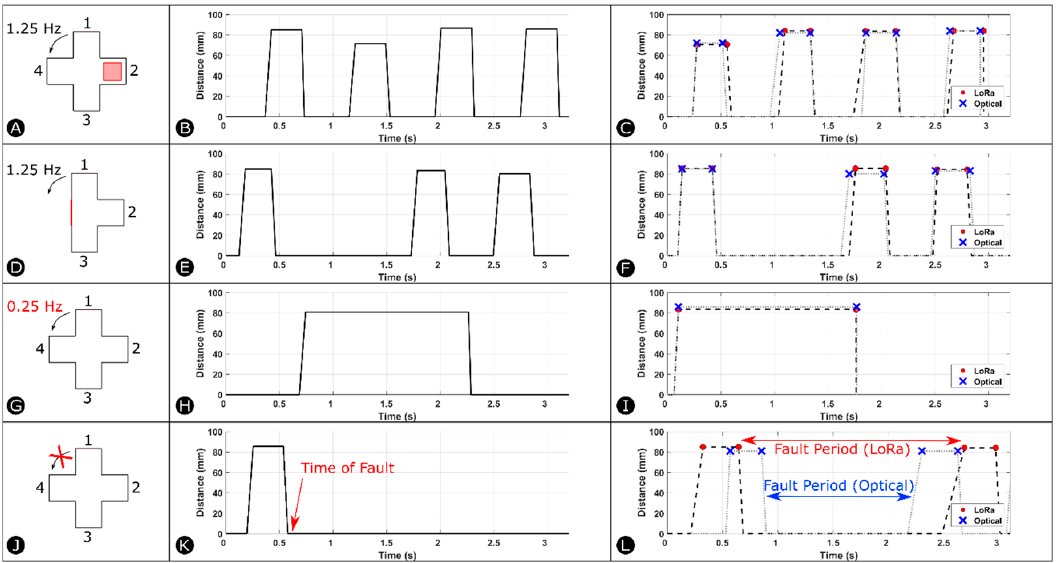
Figure 5. Schematic of ( A ) Fault 1, ( B ) Fault 2, ( C ) Fault 3, ( D ) Fault 4. Distance Profile of Wi-Fi communication experiment for ( E ) Fault 1, ( F ) Fault 2, ( G ) Fault 3, ( H ) Fault 4. Distance Profile of LoRa and optical communication experiments for ( I ) Fault 1, ( J ) Fault 2, ( K ) Fault 3, ( L ) Fault 4.